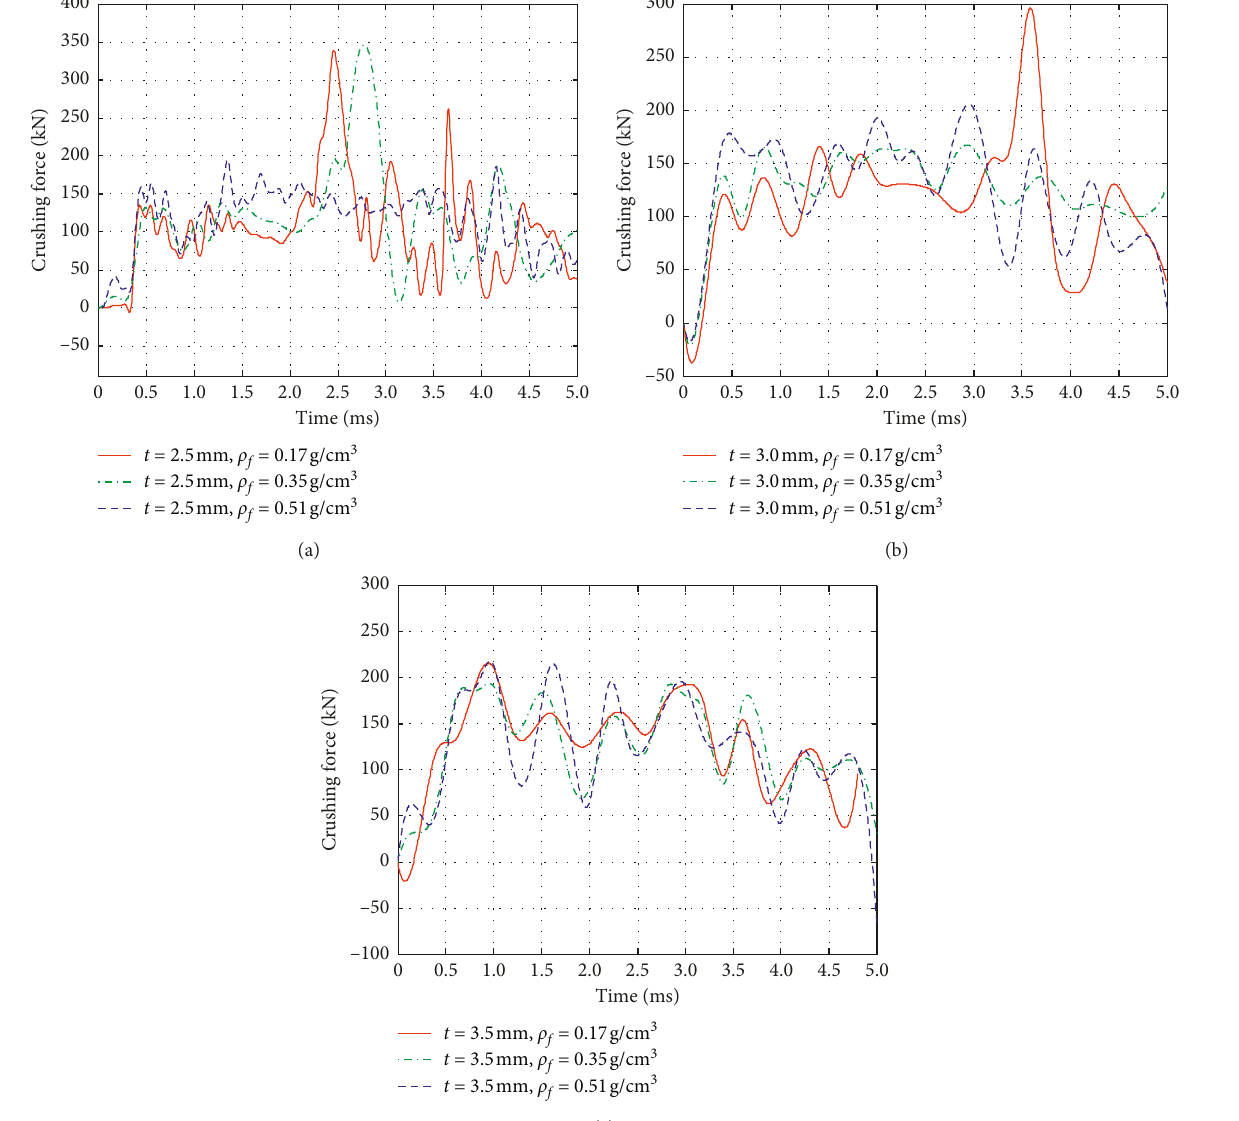
Figure 20: Crushing force-time curves of scientific instrumentation. Crushing force of FTS with a thickness of (a) 2.5mm, (b) 3.0mm, and (c) 3.5mm.